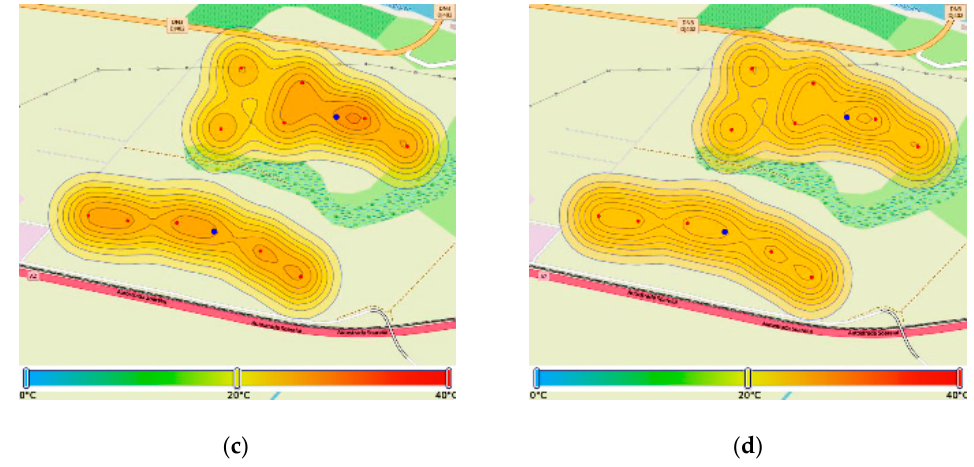
Figure 17. Temperature map in Zone 2, before and after consensus: ( a ) location of temperature sensors; ( b ) temperature map after 10 iterations; ( c ) temperature map after 20 iterations; and ( d ) temperature map after 30 iterations.